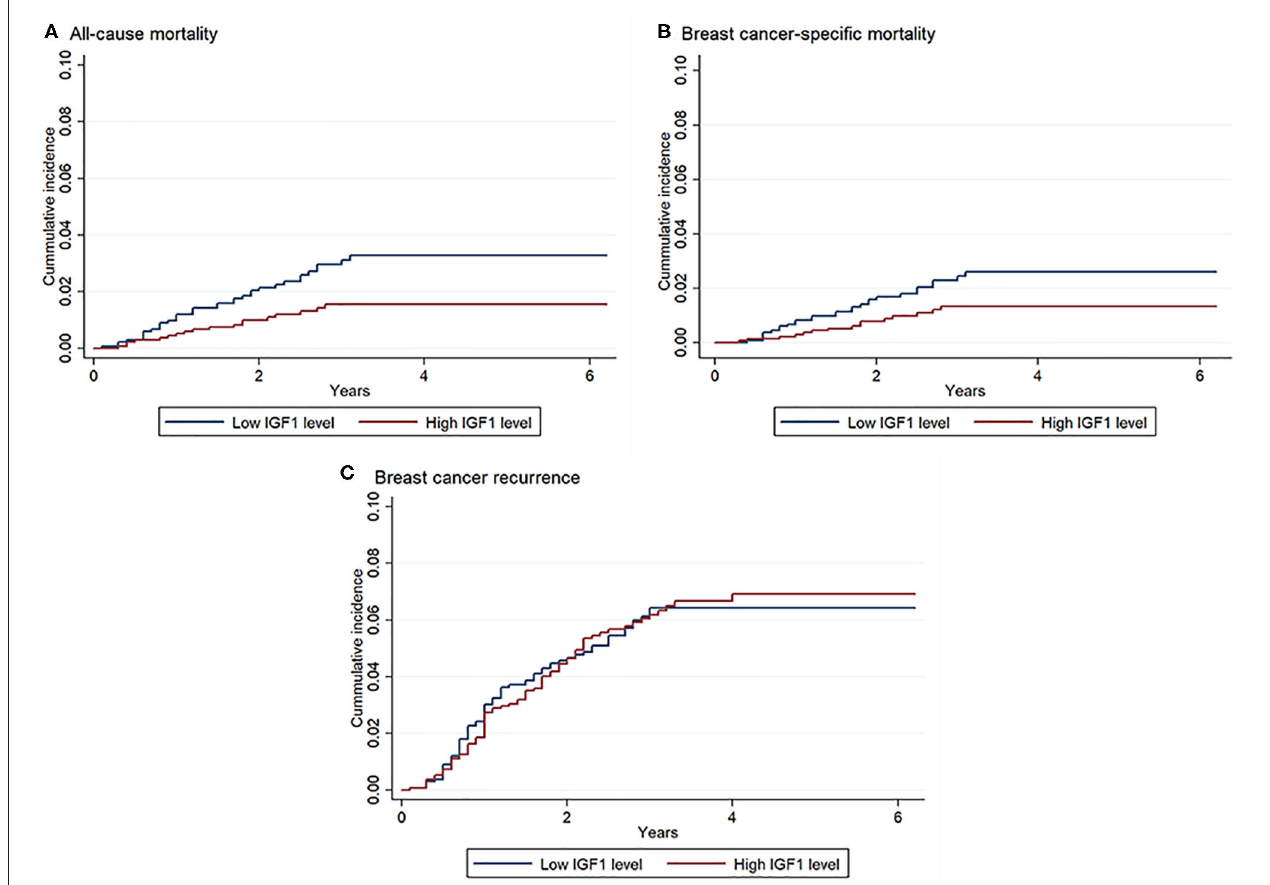
FIGURE 1 | Kaplan–Meier curves of all-cause mortality, breast cancer-specific mortality, and breast cancer recurrence according to insulin-like growth factor 1 (IGF1) levels. There were 2,682 patients included in the analysis. Log-rank test: P = 0.007 for all-cause mortality, P = 0.038 for breast cancer-specific mortality, P = 0.90 for breast cancer recurrence. (A) Association between IGF1 and all-cause mortality; (B) Association between IGF1 and breast cancer-specific mortality; (C) Association between IGF1 and breast cancer recurrence.